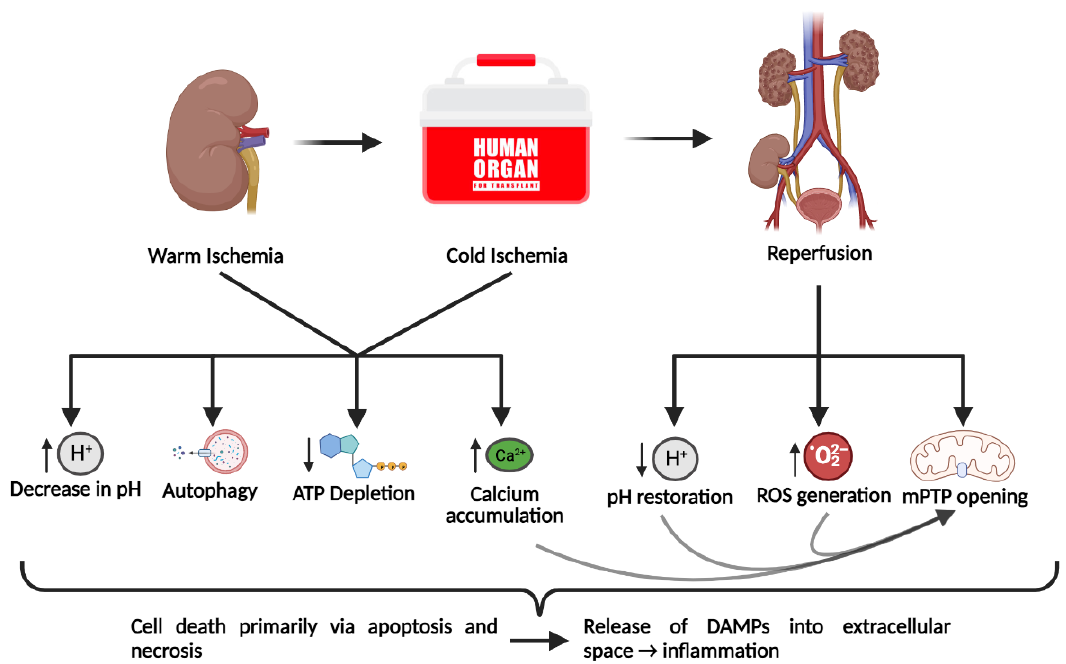
Figure 1. Cellular mechanisms of ischemia-reperfusion injury incurred through solid organ trans- plantation. The warm ischemia period begins with the interruption of perfusion to the donor organ and continues until the organ is flushed with hypothermic preservation solution, which marks the beginning of cold ischemia. The cold ischemic period typically consists of 4 ◦ C cold storage of the procured organ and continues until the graft is implanted into the recipient. Together, these two ischemic periods lead to the generation of a pathological state that is included in the depletion of ATP due to the unavailability of oxygen, calcium accumulation, and decrease in cellular pH due to altered ion channel activity, and autophagy, which likely occurs to provide a source of energy. is exacerbated. The restoration of blood flow rapidly restores pH levels and leads to the massive generation of reactive oxygen species (ROS), which together with the high intracellular calcium concentration can induce the opening of mitochondrial permeability transition pores (mPTP). Collec- tively, these effects can induce cell death, primarily via apoptosis and necrosis. Necrotic cell death releases danger-associated molecular patterns (DAMPs) into the extracellular space and leads to an inflammatory response. Figure created with